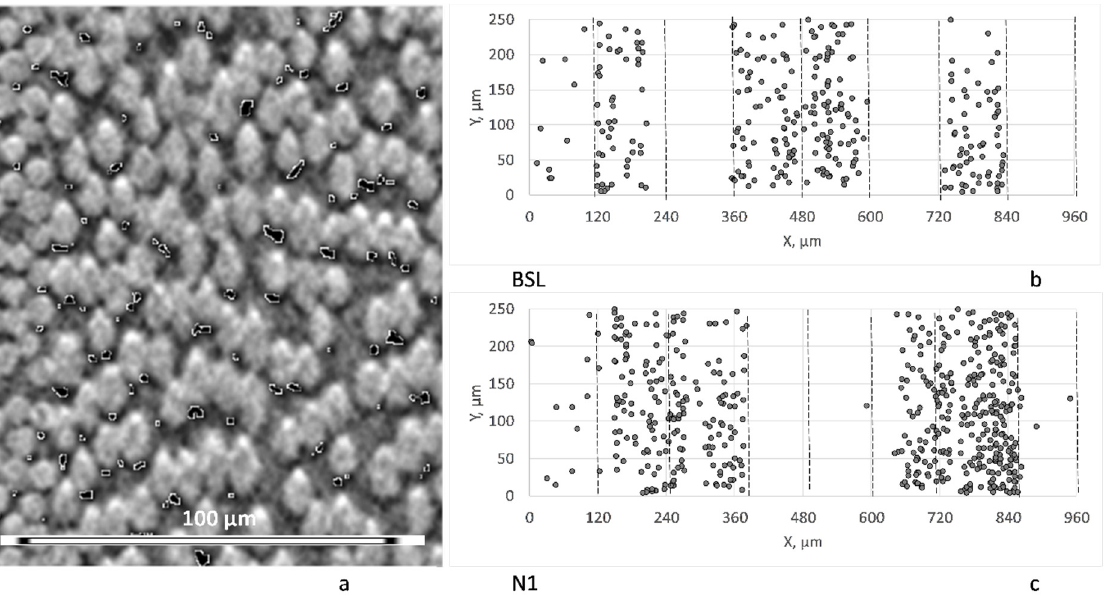
Figure 4. Voids-like artefacts: ( a ) artefacts indicated by boundaries of a 30-threshold level; ( b , c ) positions of artefacts in the BSL ( b ) and N1 ( c ) images; dashed lines indicate plies’ boundaries.